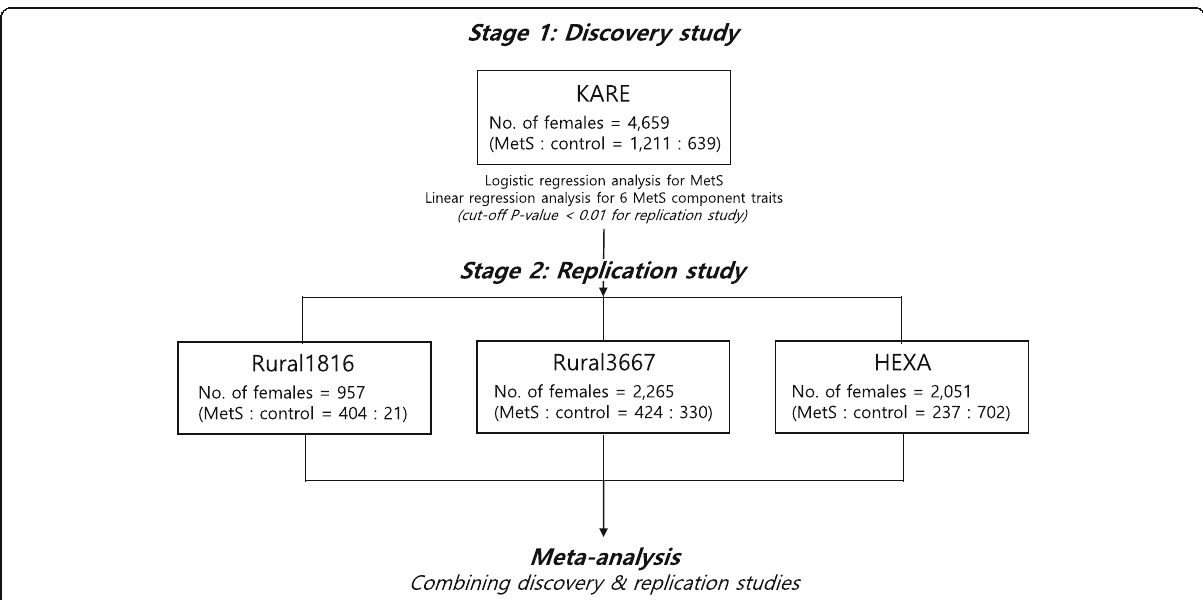
Fig. 1 Overall study work flow of two stage genome-wide association analysis for MetS and its component